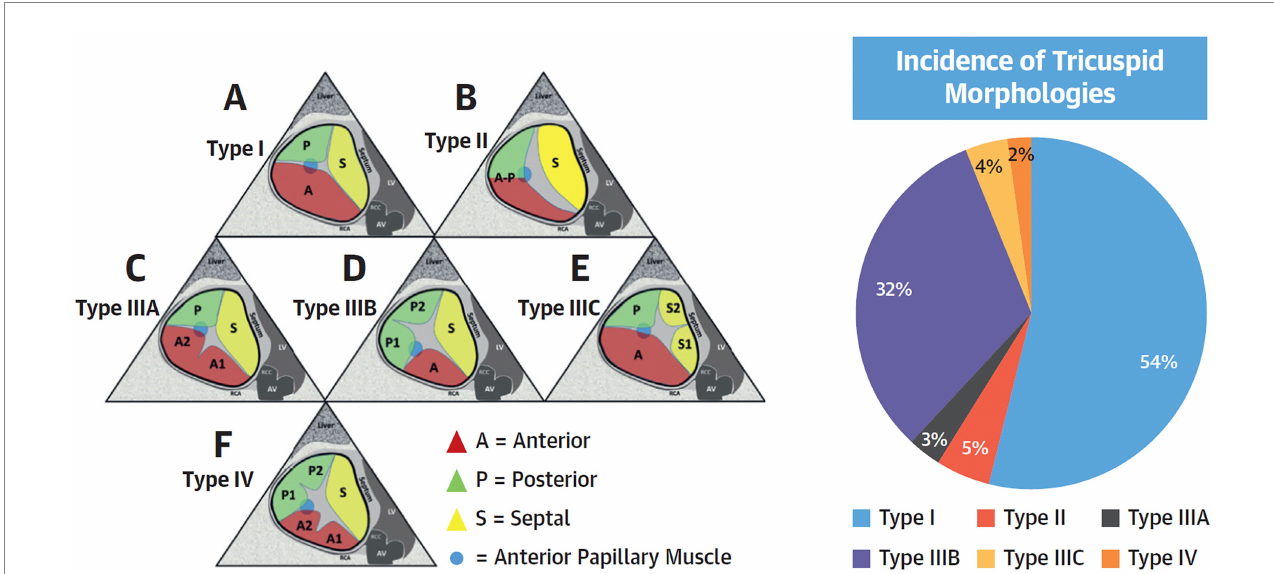
FIGURE 1 Tricuspid Valve Nomenclature Classification Scheme. (Left) A proposed tricuspid valve nomenclature classification scheme is shown. The anterior papillary muscle is indicated as a blue circle and defines the separation of the anterior from the posterior leaflets. (A) Type I: 3-leaflet configuration. (B) Type II: 2-leaflet configuration. (C–E) Type III: 4-leaflet configurations. (F) Type IV: 5-leaflet configuration. (Right) Incidence of each morphology in the present study of 579 patients. Adapted version from Dr. Hahn with permission.